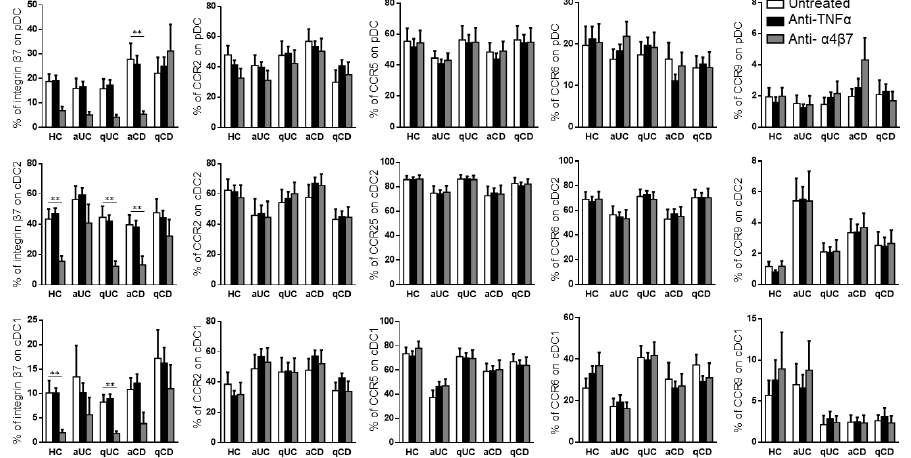
Figure 4. Vedolizumab downregulates the integrin β7 expression on circulating dendritic cell subsets. Dendritic cell (DC) subsets were identified as in Figure 1 and studied for the expressions of β7, CCR2, CCR5, CCR6 and CCR9 in healthy controls (HCs) and in patients with active ulcerative colitis (aUC), quiescent ulcerative colitis (qUC), active Crohn’s disease (aCD) and quiescent Crohn’s disease (qCD) following conditioning with an anti-TNF biological drug (black bars) or anti- α4β7 (grey bars). Results were compared with untreated controls (white bars). The percentages of positive cells were determined within each different subset (mean ± SEM n = 13–15). Two-way ANOVA with the subsequent post hoc correction was performed in order to compare integrin β7, CCR2, CCR5, CCR6 and CCR9 expression levels on pDCs, cDC2 and cDC1 from HCs and patients with a different disease status between cells subjected to different treatments, as described above. p -values < 0.05 were considered significant (** < 0.01).